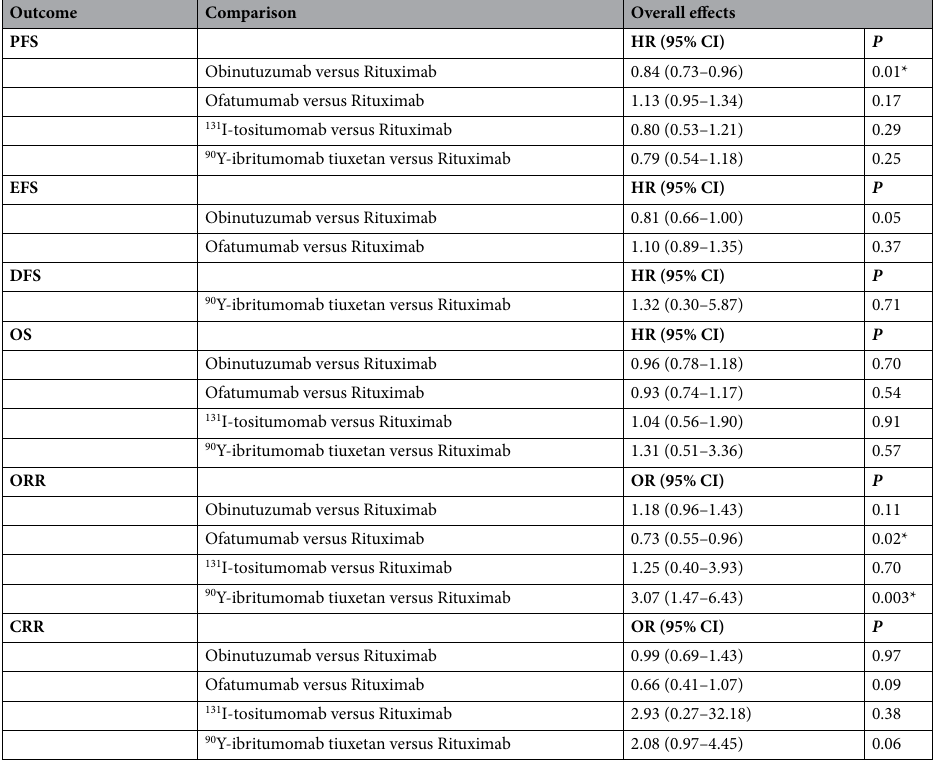
Table 2. Summary of results of all included efficacy outcomes for each comparison. PFS progression-free survival, EFS event-free survival, OS overall survival, ORR overall response rate, CRR complete response rate, HR hazard ratio, OR odds ratios, 95% CI 95% confidence interval. *Statistically significant results ( P <